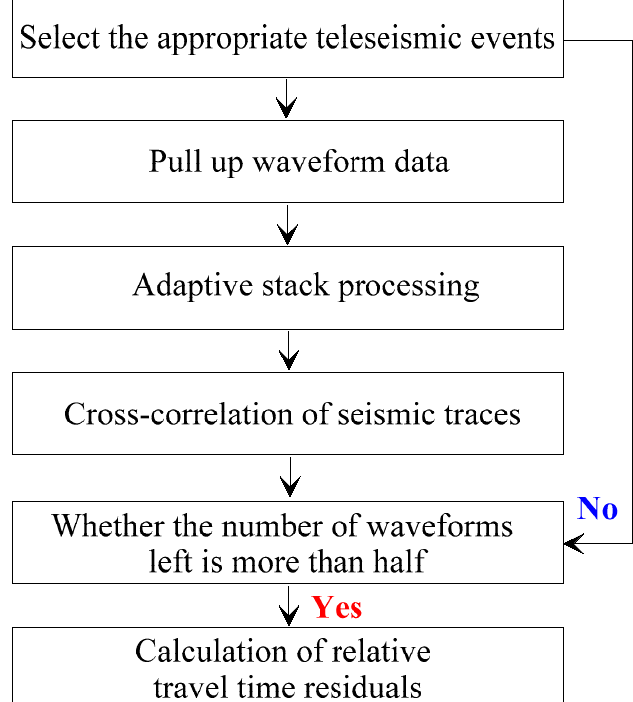
Figure 5. Flow chart of picking up relative travel time residuals.